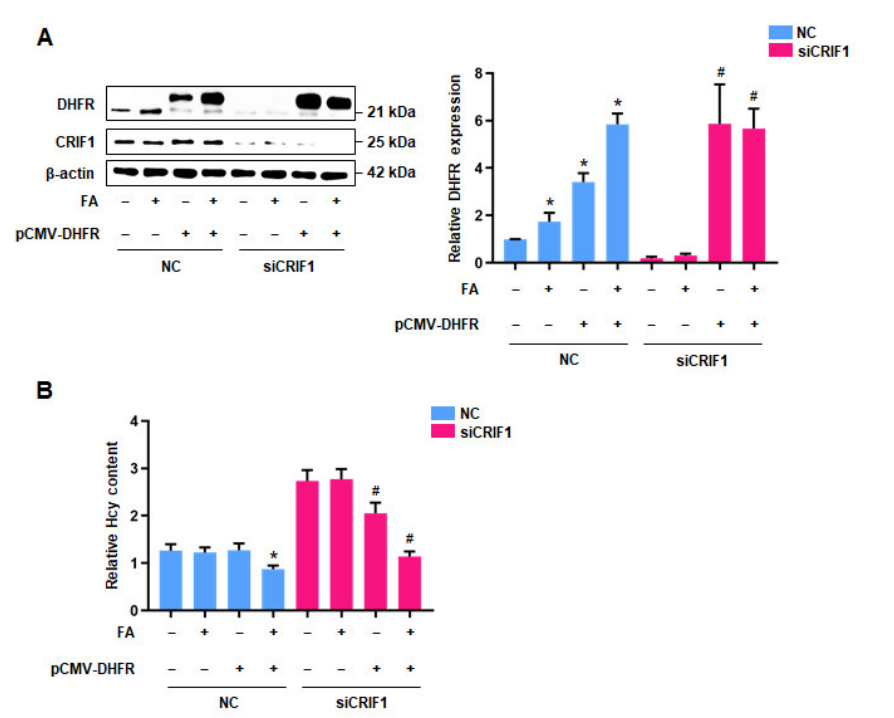
Figure 4. The effect of DHFR overexpression on Hcy regulation in HUVECs: ( A ) Western blot analysis for DHFR protein level using NC or siRNA-transfected HUVECs followed by pCMV-DHFR and FA treatments. ( B ) Relative quantification of the Hcy level of FA and pCMV-DHFR treatments after CRIF1 siRNA transfection. Data are presented with three independent experiments as the mean ± SEM. * p < 0.05 versus NC-treated cells without FA and pCMV-DHFR in the NC group, # p < 0.05 versus siCRIF1-treated cells without FA and pCMV-DHFR in the siCRIF1 group.